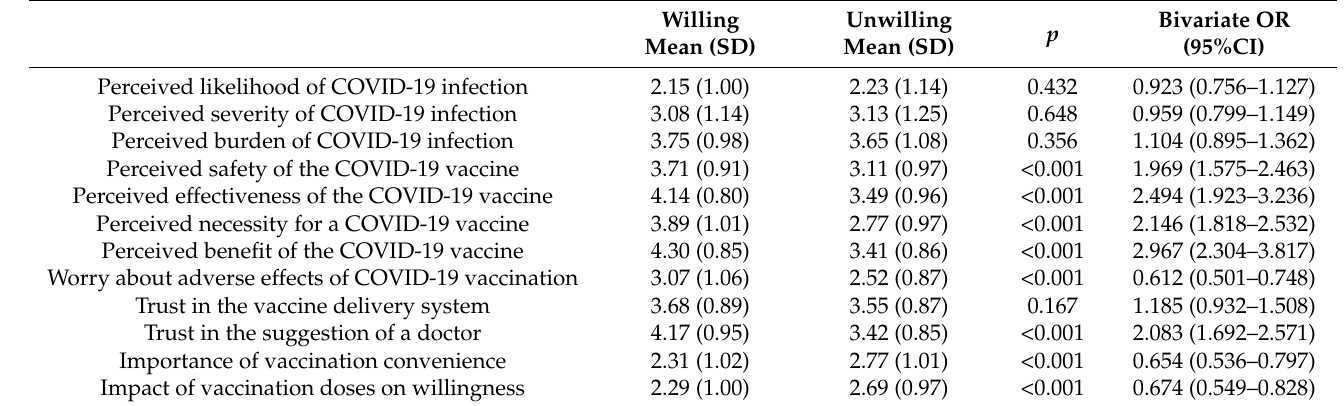
Table 3. Factors associated with attitude scores toward COVID-19 disease and COVID-19 vaccination among older people in Shanghai.